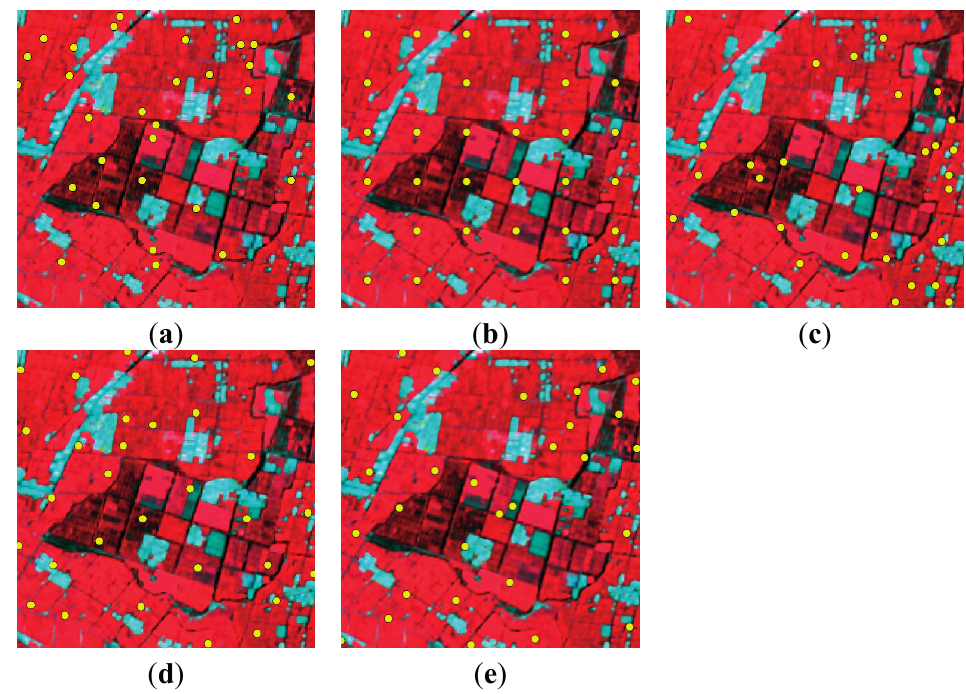
Figure 6. The spatial distribution of ESUs obtained using the ( a ) random sampling; ( b ) systematic sampling; ( c ) land-cover map; ( d ) SSVIP and ( e ) SMP methods with 30 ESUs. ESUs located in non-vegetated areas were removed in the systematic sampling approach.